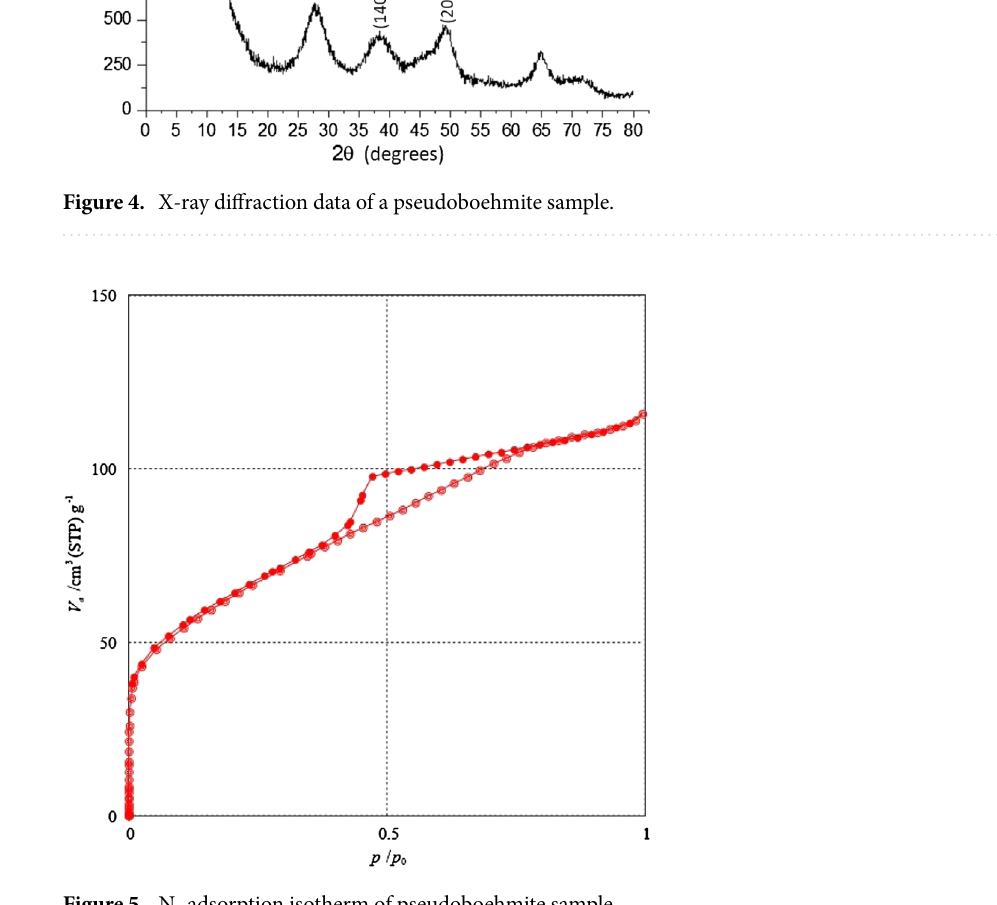
Figure 5. N 2 adsorption isotherm of pseudoboehmite